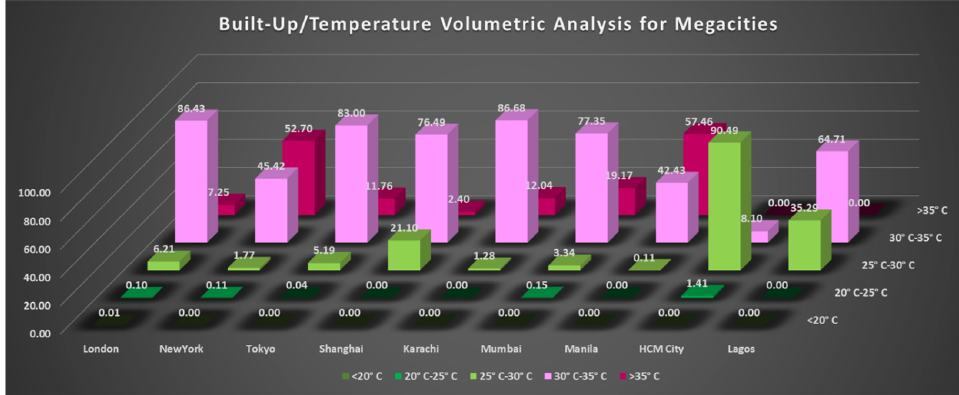
Figure 8. Visualization of volumetric analysis of UHP classes of megacities.